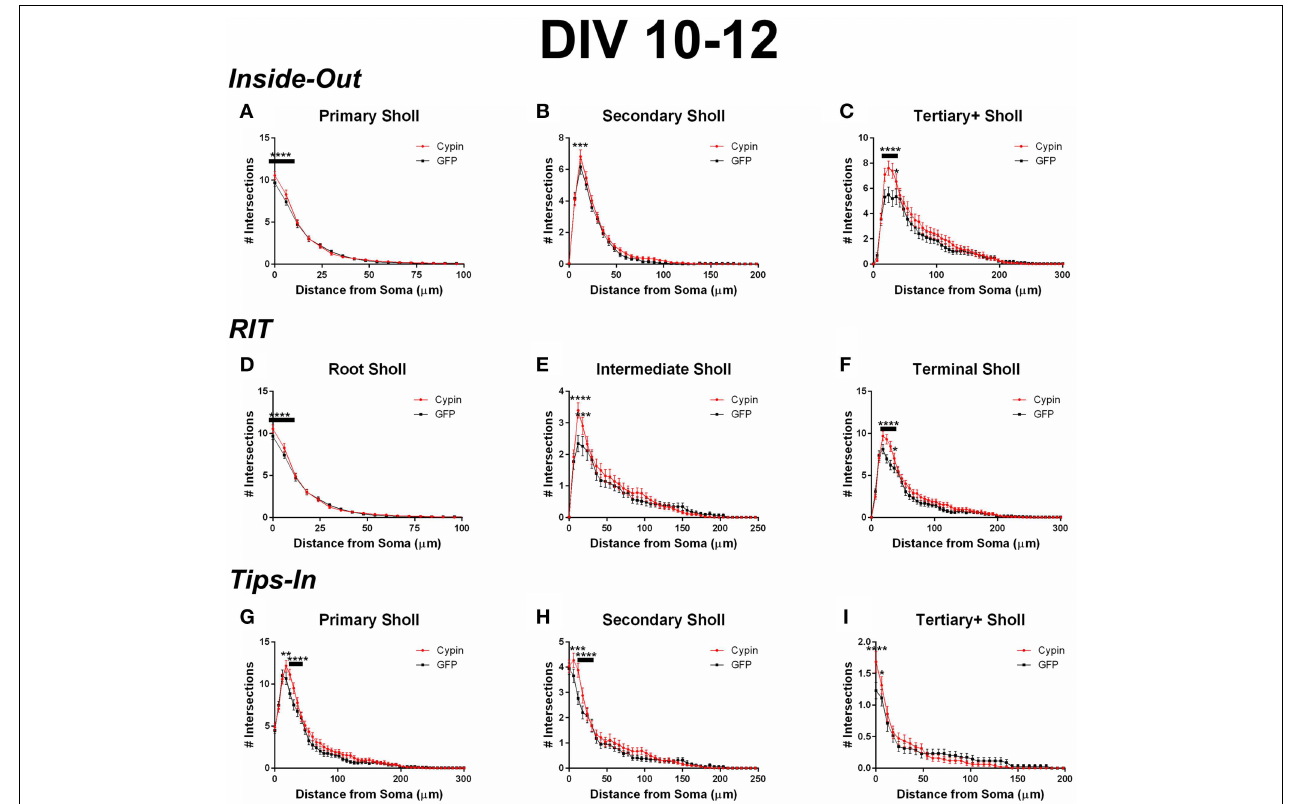
FIGURE 7 | Sholl analysis using three different labeling methods for neurons overexpressing cypin from DIV 10–12. (A–C) Sholl analysis using Inside-Out (conventional) labeling method. (A) Sholl analysis of primary dendrites (Primary Sholl) shows that overexpression of cypin significantly increases branching at 0–6 µ m from the soma ( **** p < 0 . 0001 ). (B) Sholl analysis of secondary dendrites (Secondary Sholl) shows that overexpression of cypin significantly increases branching at 12 µ m from the soma ( *** p < 0 . 01 ). (C) Sholl analysis of tertiary and higher order dendrites (Tertiary + Sholl) shows that overexpression of cypin significantly increases branching at 18–30 µ m from the soma ( **** p < 0 . 0001 ) and at 36 µ m from the soma ( * p < 0 . 05 ). (D–F) Sholl analysis using RIT labeling method. (D) Sholl analysis of root dendrites (Root Sholl) shows that overexpression of cypin significantly increases branching at 0–6 µ m from the soma ( **** p < 0 . 0001 ). (E) Sholl analysis of intermediate dendrites (Intermediate Sholl) shows that overexpression of cypin significantly increases dendrite